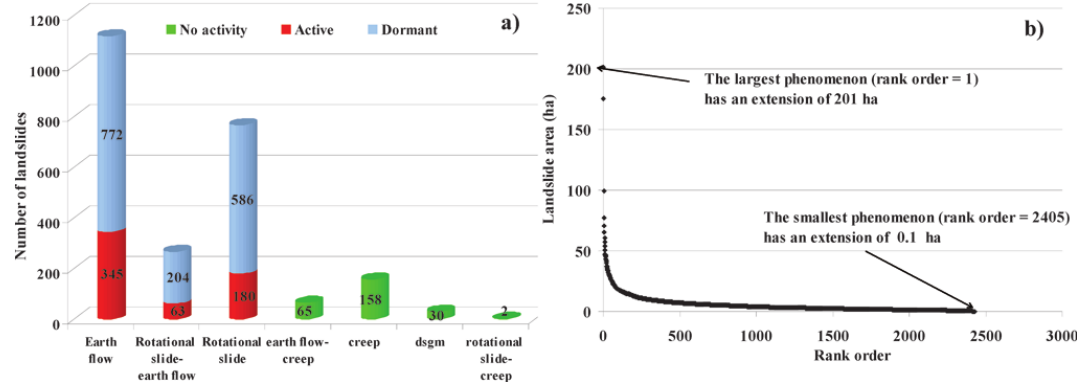
Fig. 3. (a) Number and state of activity of mapped phenomena distinguished per types within the test area; (b) distribution of slow-moving landslide extension within the test